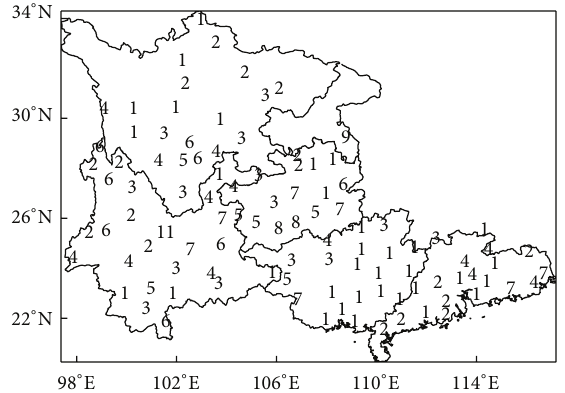
Figure 6: Cumulative months of negative precipitation accumula- tion: October 2009–March